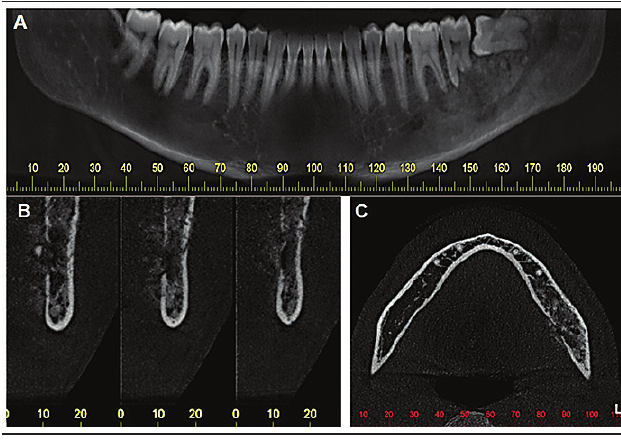
FigurE 1 − Cone-beam CT scan of the patient A) panoramic reconstruction, showing a mixed lesion in the mandible posterior region, with poorly defined limits, which caused partial reabsorption of the distal root of the tooth 37; B) coronal sections exhibiting periosteal osteophytic reaction with “sun ray” appearance in the mandibular lingual cortical; C) axial section showing hyperdense mandibular medullary bone, on the left side. CT: computed tomography. FigurE 2 − Three-dimensional reconstruction of left posterior mandibular region, showing loss of continuity of buccal (A) and lingual (B) cortical plates Histological sections stained with hematoxylin and eosin (HE)